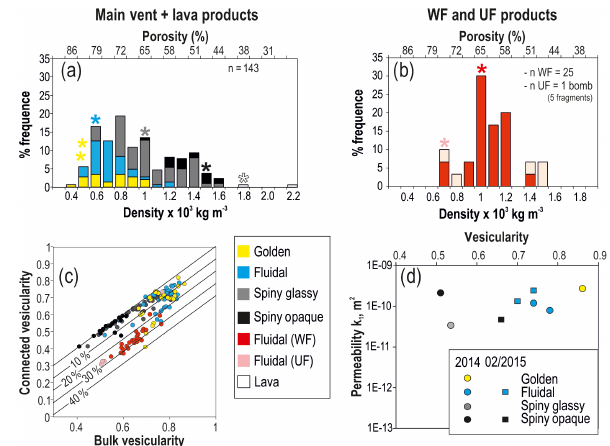
Figure 6. Density, connectivity, and permeability data of June 2014 pyroclast and lava fragments: (a) density distribution histogram for all the pyroclast fragments measured at the MV + two lava frag- ments collected from the eastern front of the lava flow (see Fig. 1 for location). n is the number of measured clasts; (b) density dis- tribution histogram for the pyroclasts sampled at the WF and the bomb sampled at the UF. The bomb broke in five fragments (two fragments from the core, the least dense, and three fragments from the quenched edges, the densest). In both the density histograms the stars represent the density intervals from which we picked the clasts for the textural measurements; (c) graph of the connected vesicu- larity versus total vesicularity. The diagonal line represents equality between the connectivity and vesicularity; beneath this line the sam- ples have isolated vesicles and the straight lines represent lines of equal fraction of isolated vesicles. Note that the bomb from the UF has the high vesicular core with less than 5% of isolated vesicles, while the three low vesicular fragments from the quenched edge have more than 25% of isolated vesicles (see pink spots); (d) Dar- cian viscous permeability ( k 1 ) versus vesicularity fraction for the four typologies of clasts collected at the MV. For comparison, two fluidal fragments and one spiny opaque fragment from the Febru- ary 2015 eruption are